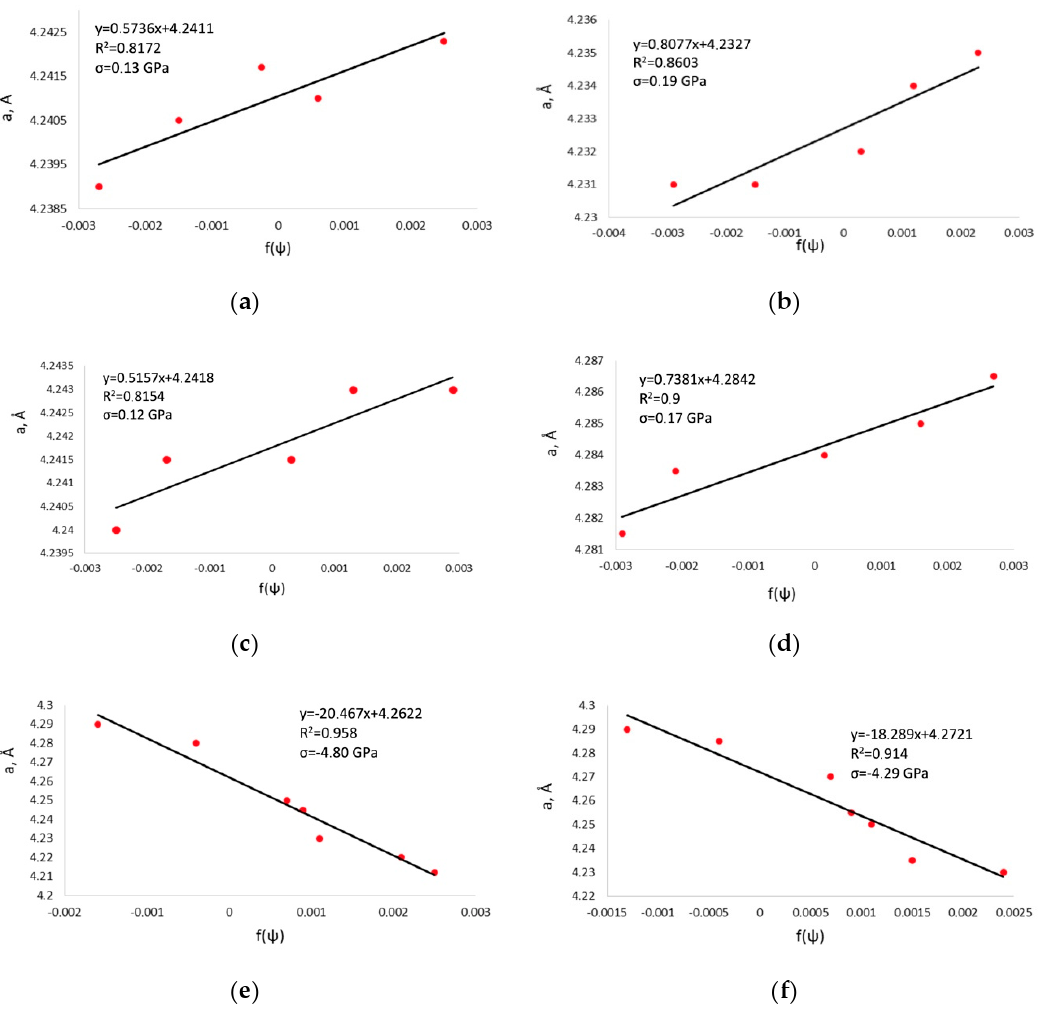
s 2 sin 2 ψ + 2 s 1 for the coatings: 2